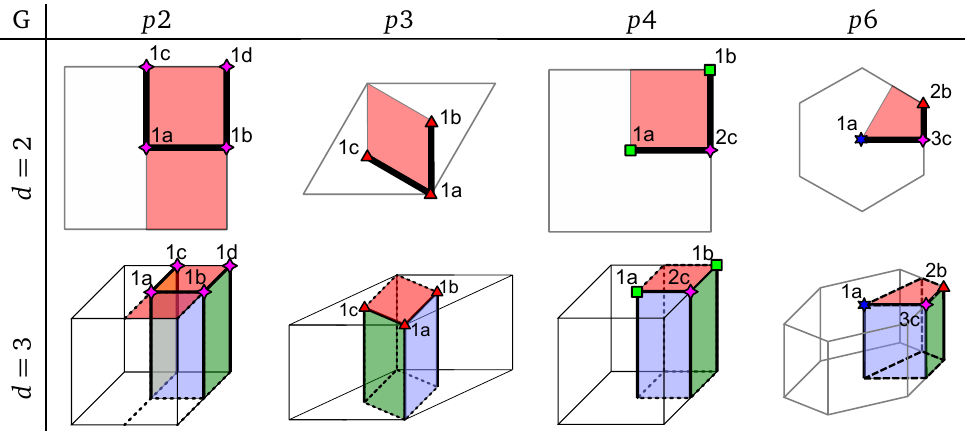
Figure 5: Cell decompositions of unit cells in space group G in dimensions d = 2,3: Pink stars, red triangles, green squares and blue stars denote inequivalent twofold, threefold, fourfold and sixfold rotation axes, respectively. Colored areas and bold lines denote inequivalent 2-cells and 1-cells, respectively. In two dimensions, the 2-cell is the asymmetric unit. The 0-cells coincide with the rotation axis. In three dimensions, the asymmetric unit is a 3-cell whose hinges are denoted by dotted lines. The 0-cells lie at the end of the rotation axes. We use the standard labels for Wyckoff